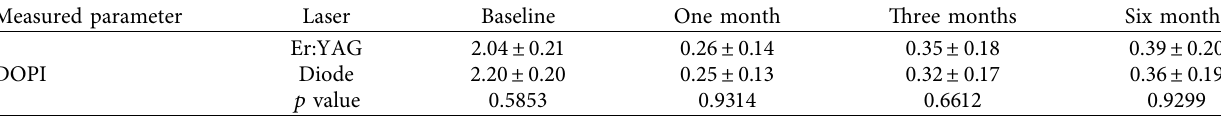
Table 5: Degree of pigmentation index (DOPI) of Er:YAG compared to diode lasers.